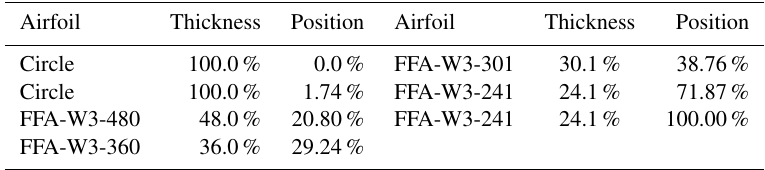
Table 3. Spanwise position of the airfoils of the blade of the 10MW